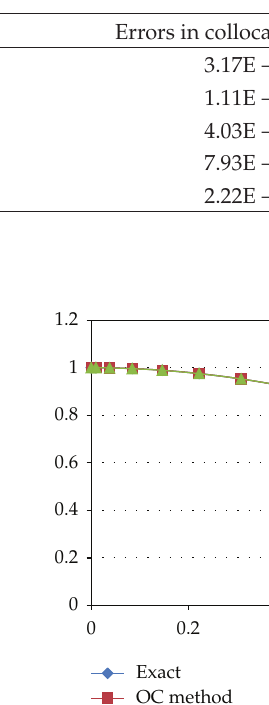
Table 1: Maximum errors for collocation and OC methods.